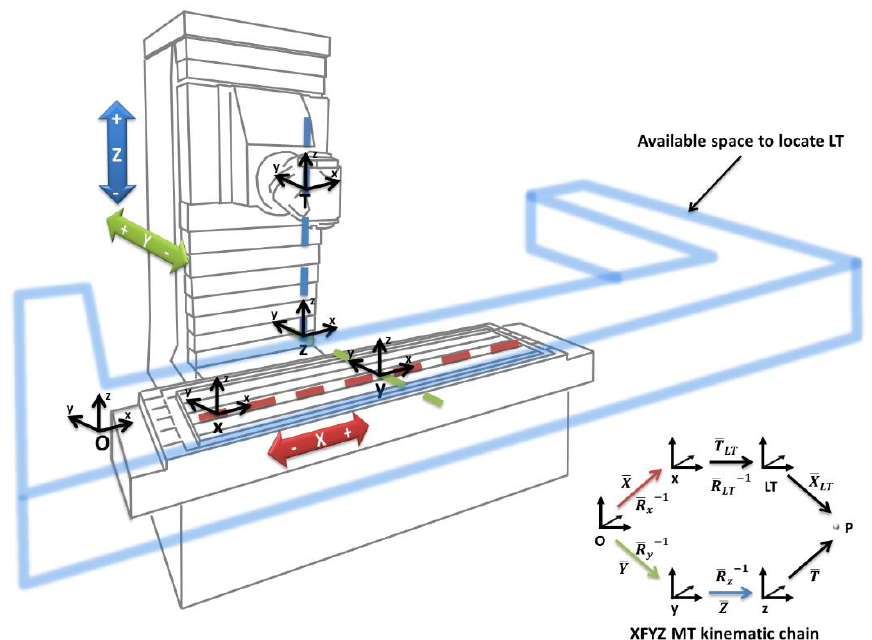
Figure 2. Machine tools (MTs) kinematic chain with XFYZ configuration, where F determines the fixed part of the machine, X represents the axis that moves the part and the LT during the verification process, and Y and Z represent the axes that move with the tool. Laser tracker (LT).